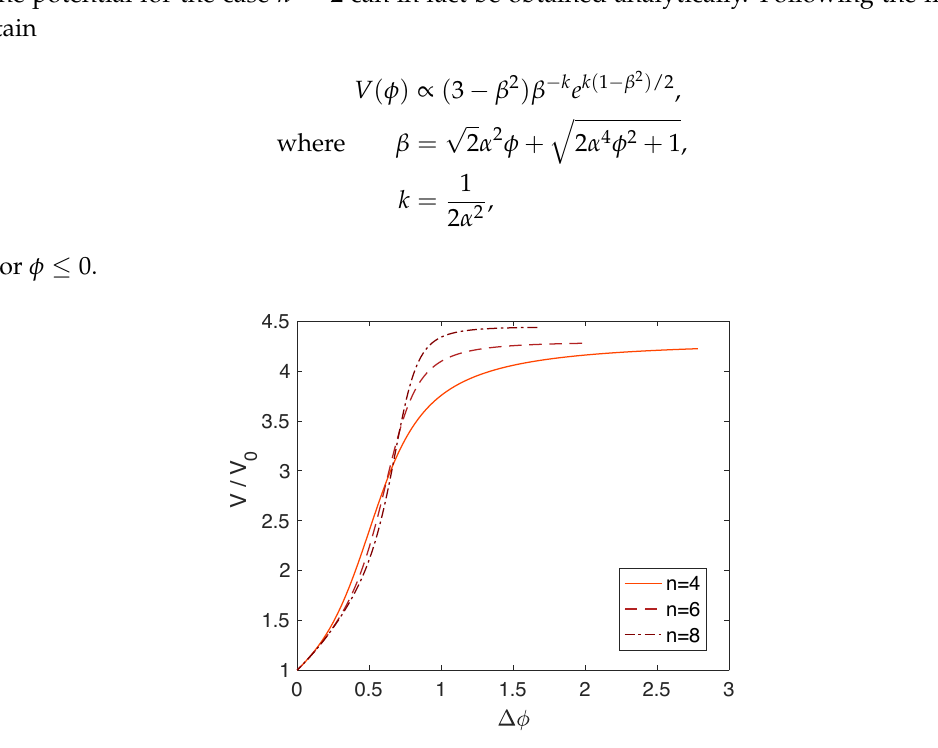
Figure 1. The inflaton potential V ( φ ) / V ( 0 ) for the Generalised Gaussian model H ∝ exp ( − φ n ) , with n = 4,6,8. On each curve, the bottom left corner marks the end of inflation at φ = 0. All these potentials are consistent with Planck’s constraints in the ( n s , r )